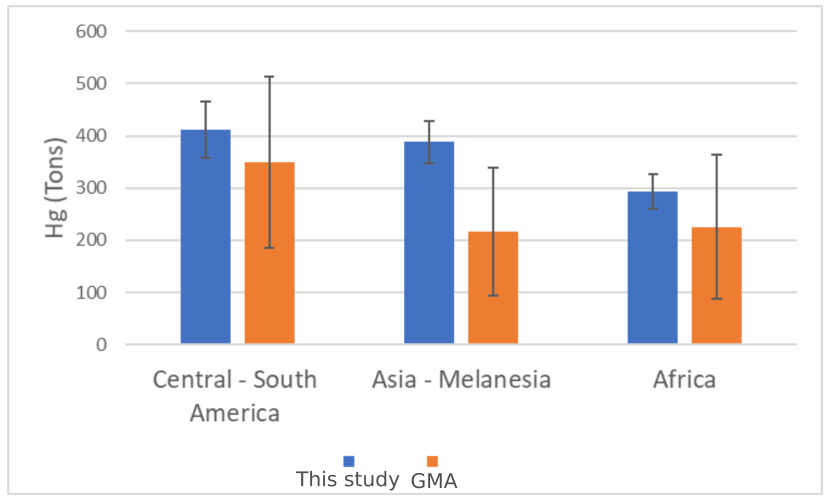
Figure 3. ASGM Hg emissions estimated in this study grouped by macro-area. Estimates from GMA are also reported for comparison